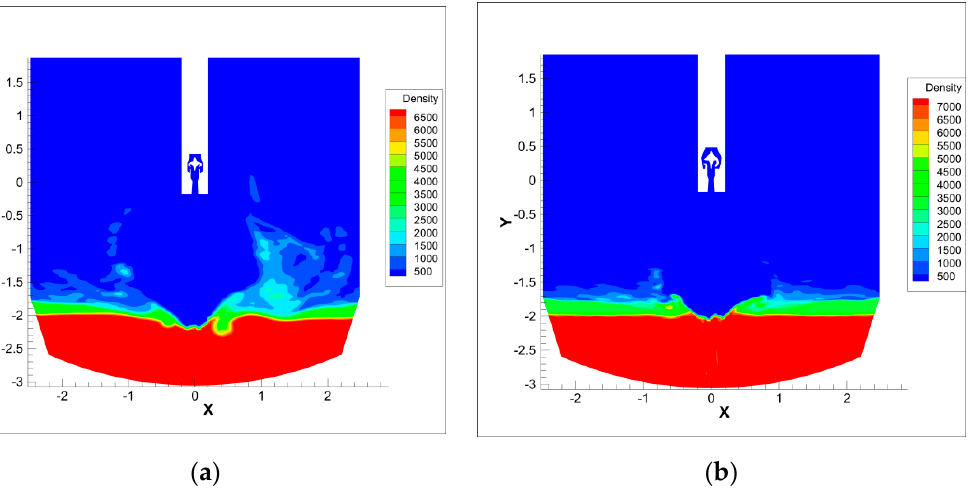
( b ) velocity contours and vector diagrams of the third layer of cyclone nozzle after optimization.